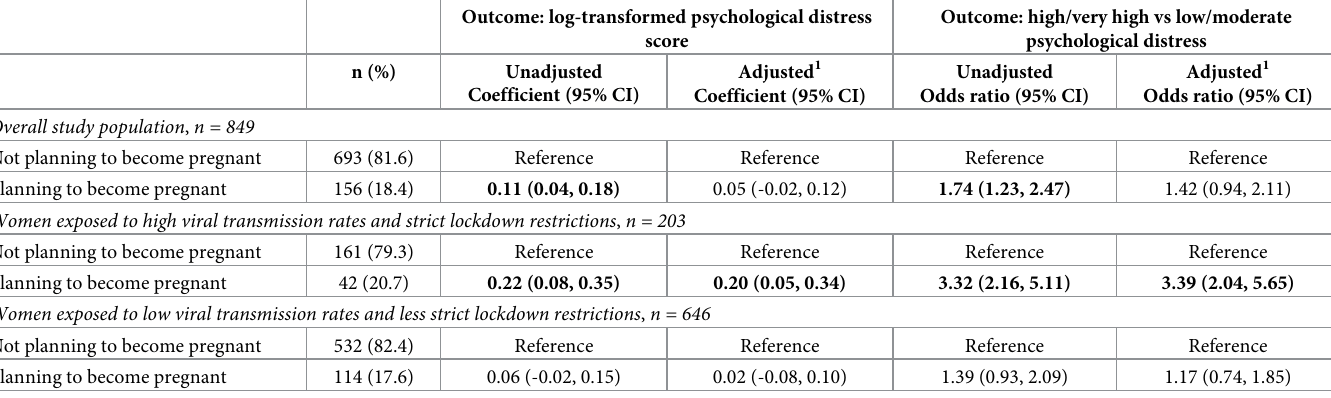
Table 2. Associations between pregnancy intention and psychological distress by level of COVID-19 transmission rates and lockdown restrictions, N =